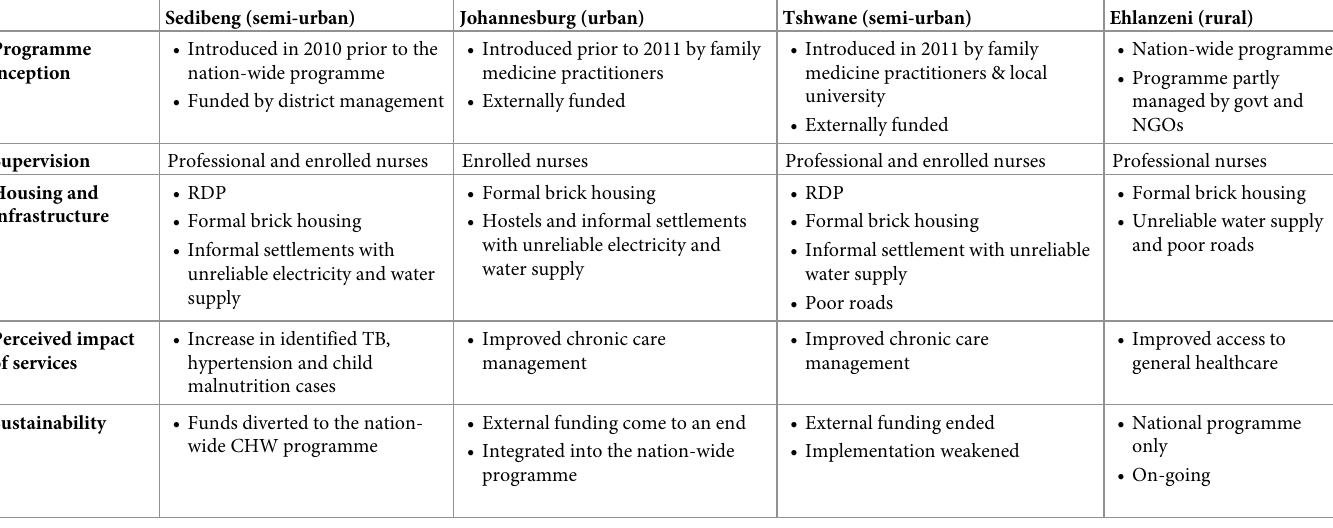
Table 5. Descriptions of the CHW programmes and the communities they